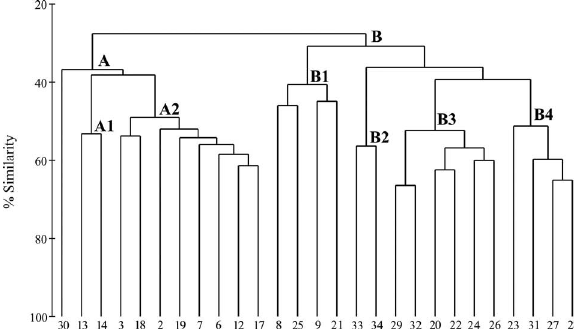
Fig . 2. – Faunal assemblages in the Ría de Aldán as determined by cluster analysis based on the Bray-Curtis similarity